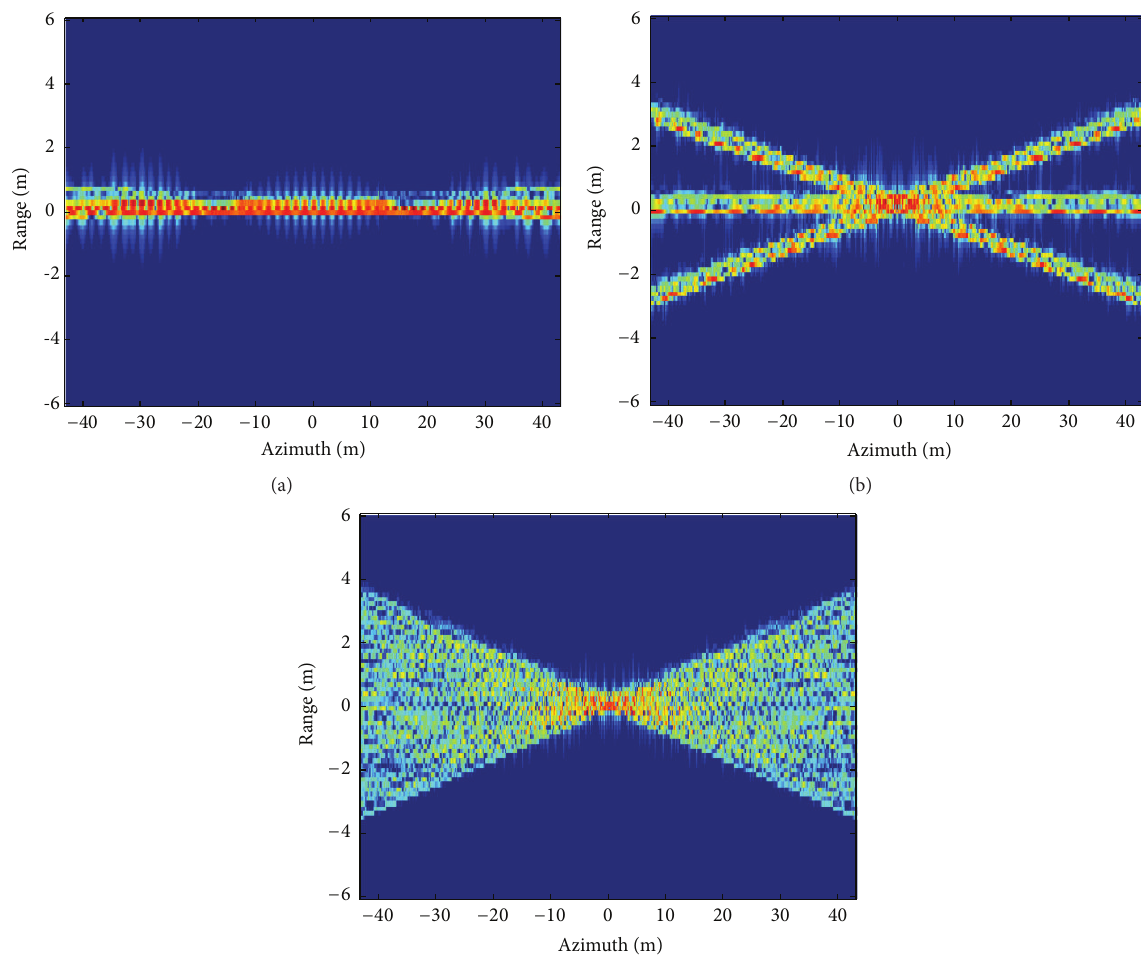
Figure 10: SAR images of an RPRA, formulated by CBP, when (a) 𝑓 𝑚 = 0.2 Hz, (b) 𝑓 𝑚 = 0.3 Hz, and (c) 𝑓 𝑚 = 2